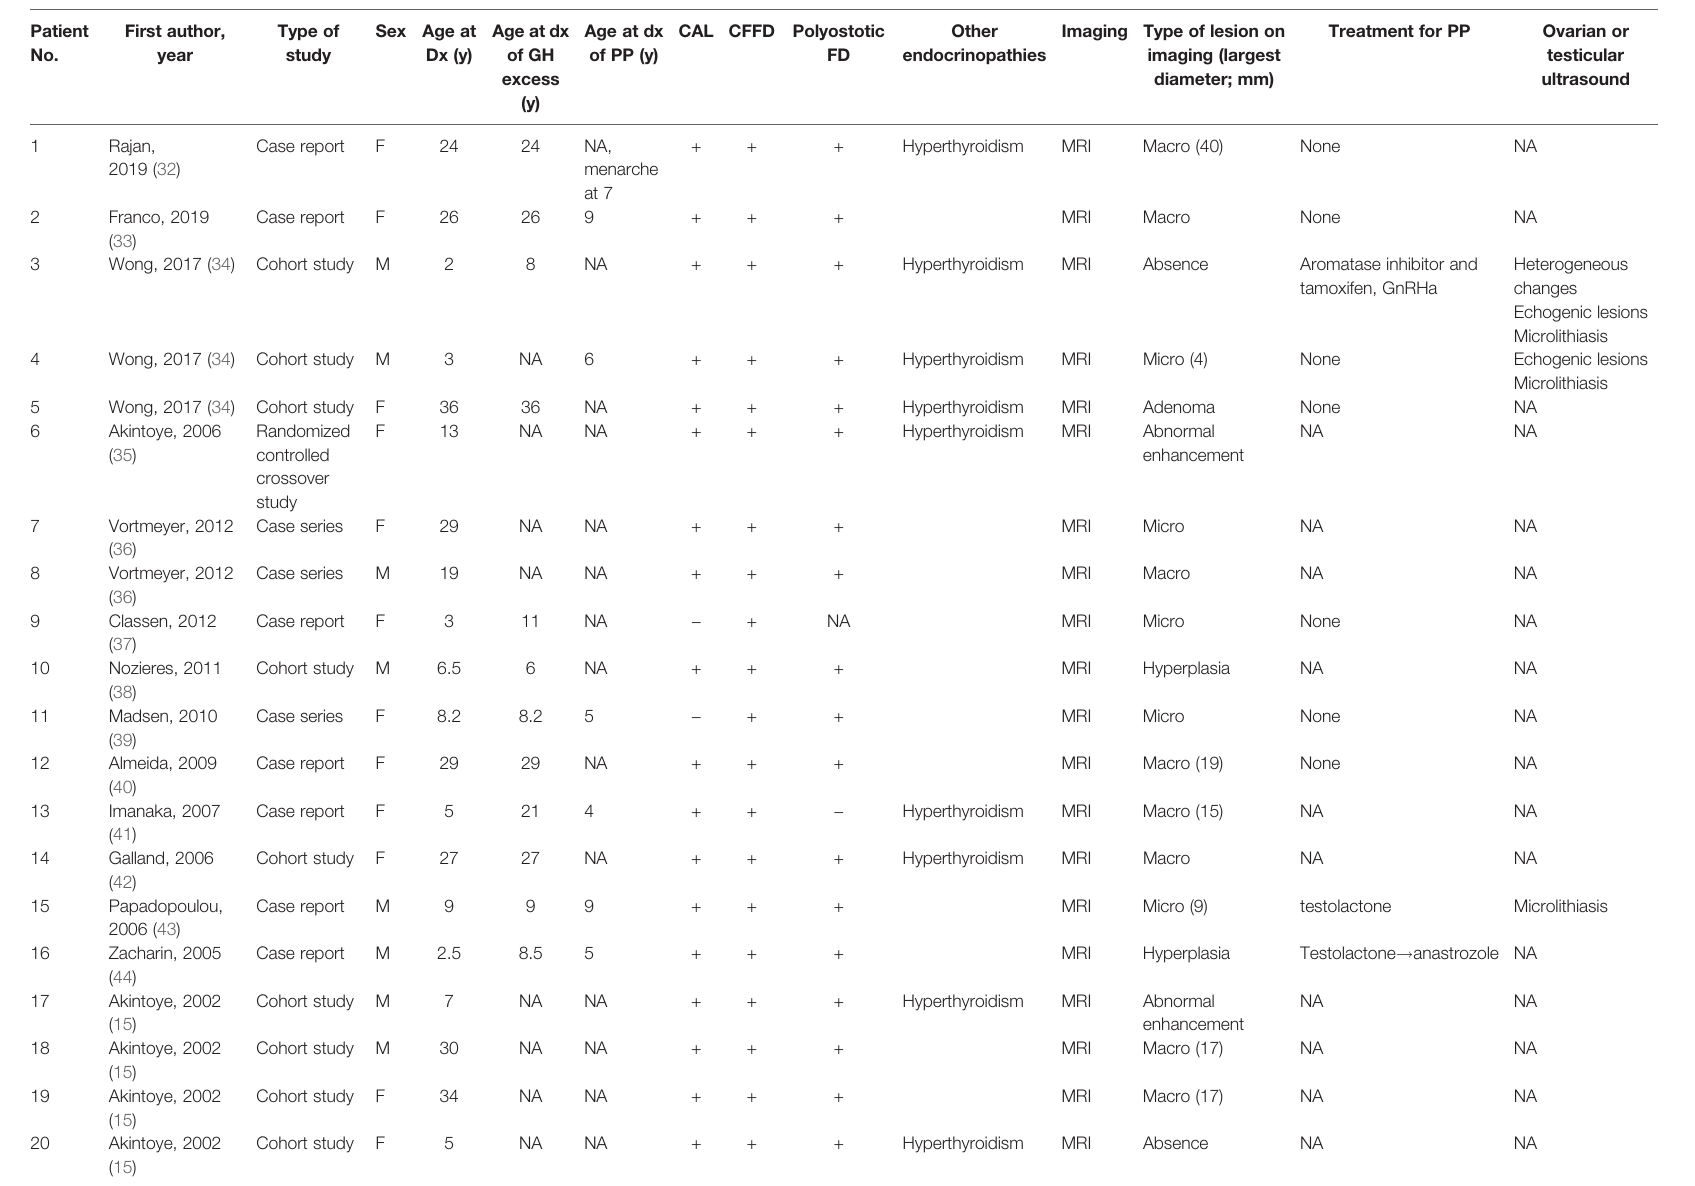
TABLE 5 | Clinical characteristics of patients from the literature review. Patient